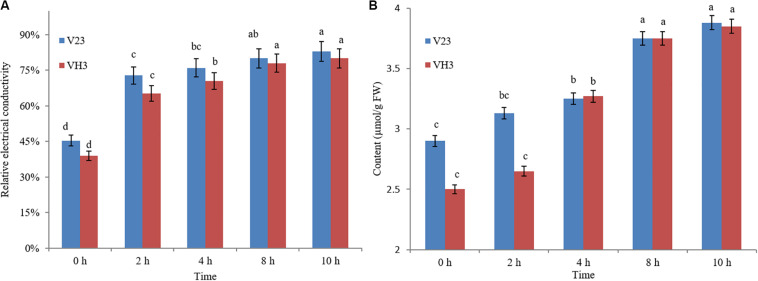
Effect of low-temperature stress on the relative conductivity (A) and MDA content (B) of V. volvacea. Comparison was conducted among different low-temperature treatment time points in the same strain (in V23 or VH3). The lowercase letters on bars represent the levels of significance. Means with the same lowercase letters at the top of the bar do not differ significantly (p < 0.05).